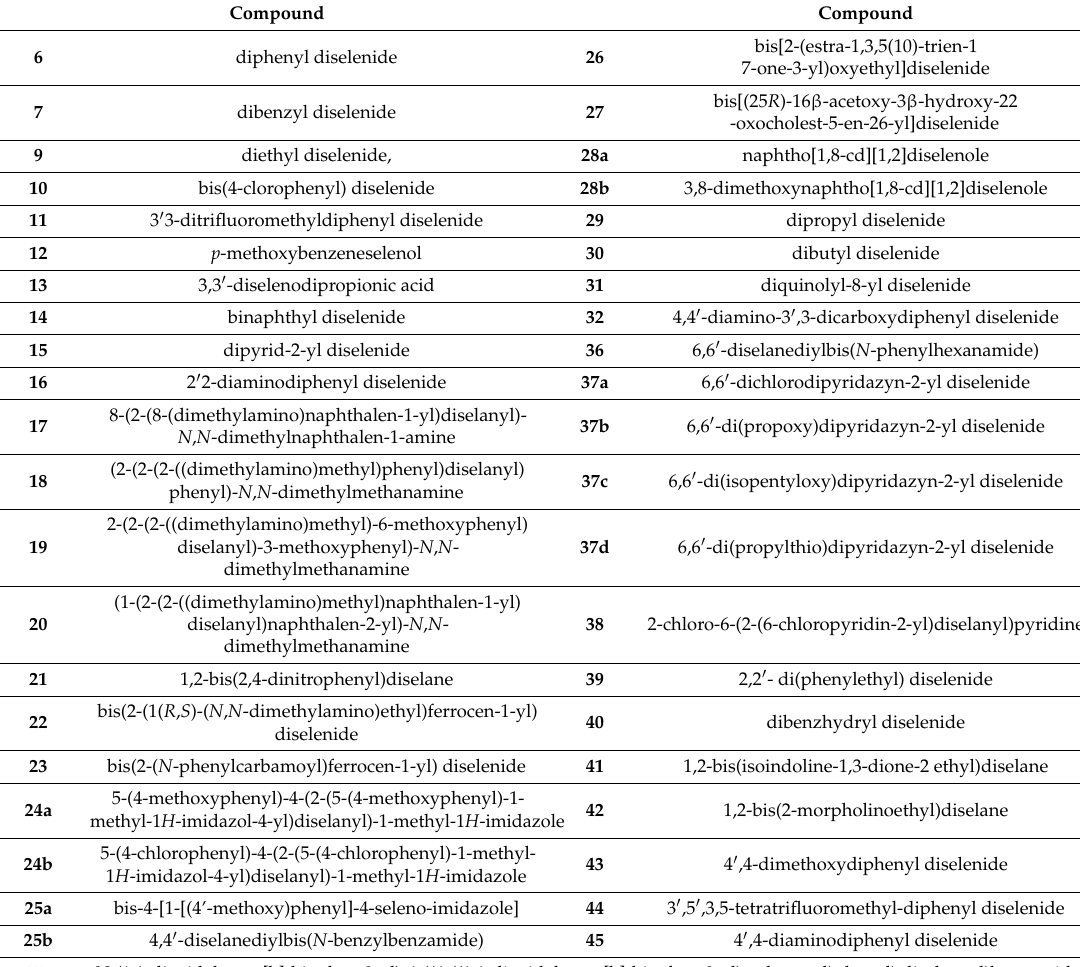
Table 1. Synthetic diselenides